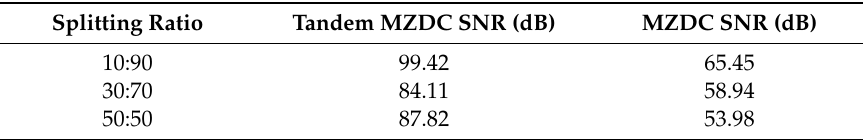
Table 5. SNR from spatial response of MZDC and tandem